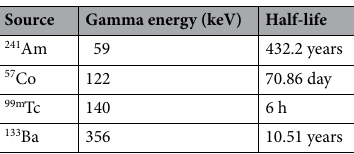
Table 3. Gamma energy sources for measuring the mass attenuation coefficient.